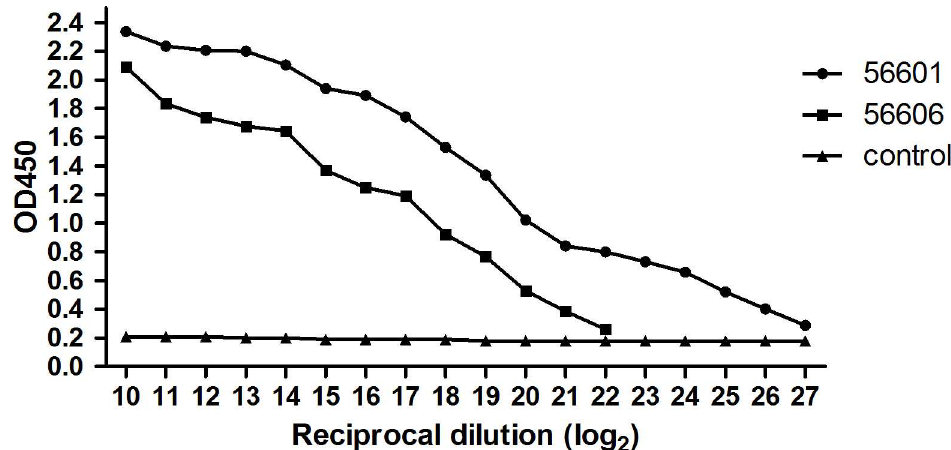
Fig 1. ELISA was used to determine the titer of IgG-pcAb. In brief, 96-wellplates were pre-coatedwith 56601 or 56606.The concentration of purifiedrabbit-raised antibodieswas adjusted to 20 mg/ml and then added to the well by a two-fold serial dilution (2 10 to 2 27 ). The OD450 was then determined.Data were presented as the mean from two separateexperiments, each individuallyconductedin